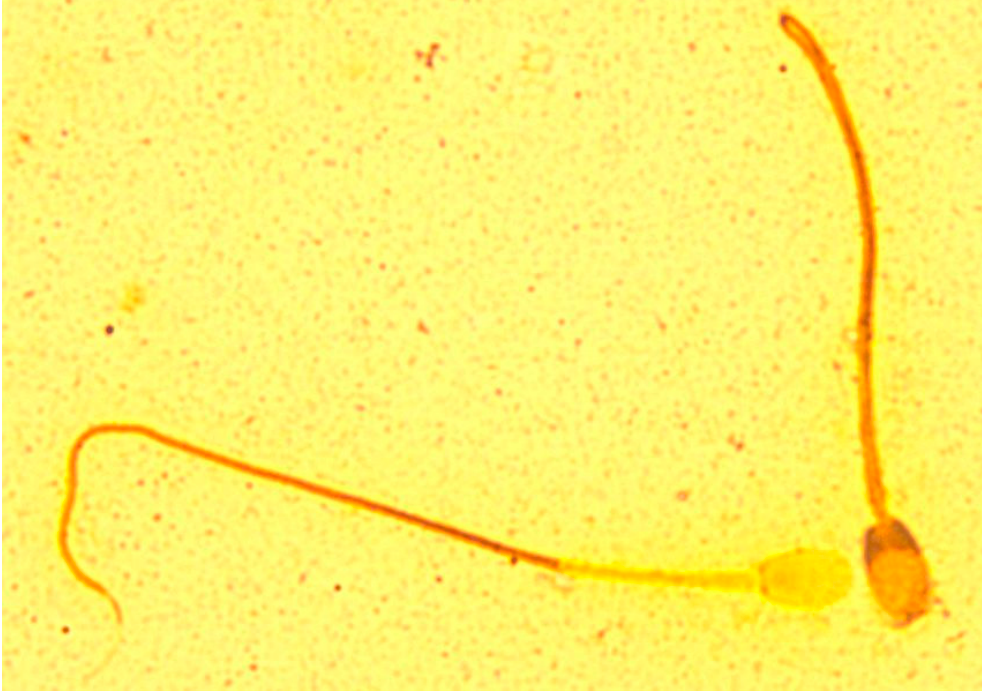
Figure 1. Spermatozoa of blue fox—silver nitrate staining revealing individual sperm structures.